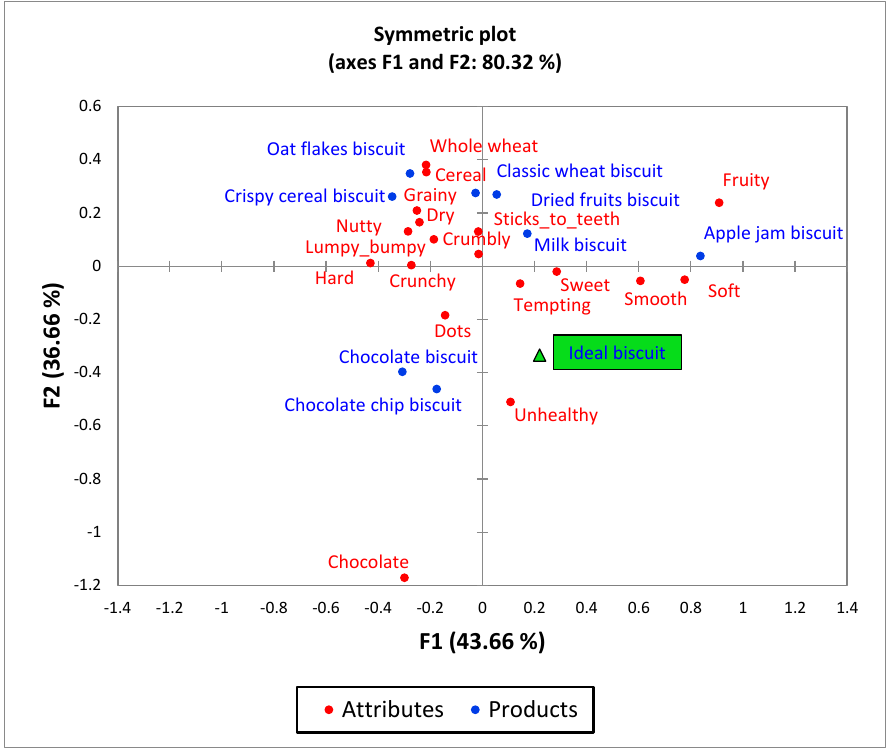
Figure 2. Symmetric plot based on CATA descriptions of 8 biscuits as well as of the children’s ideal biscuit for the whole sample of children ( n =